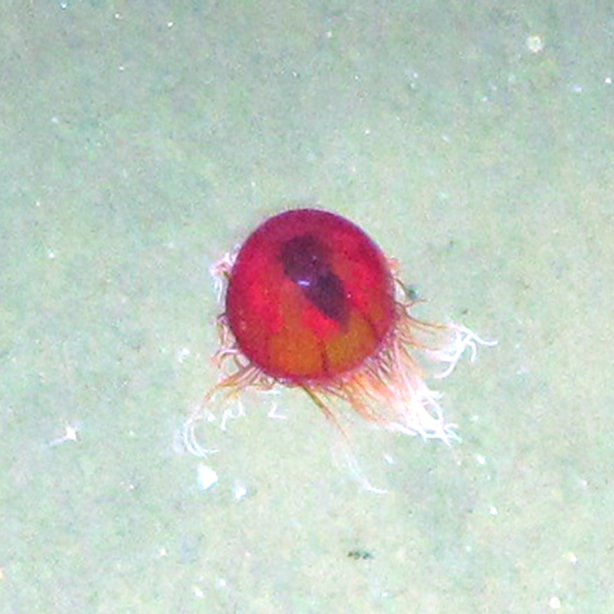

Crossota
millsae